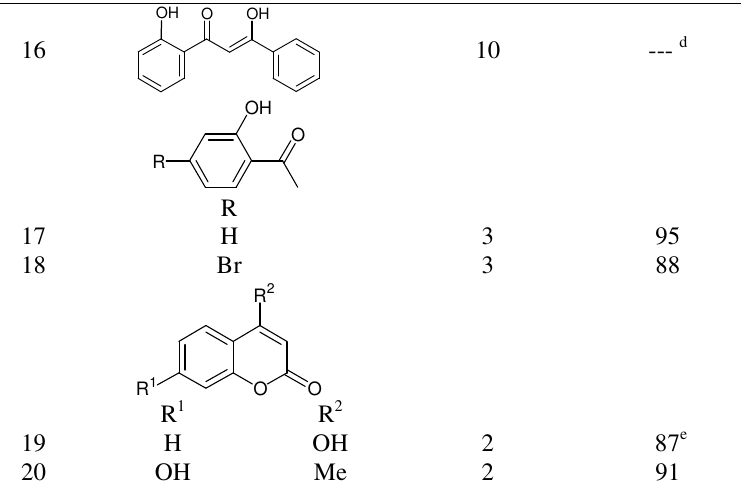
Table 3. WD-Acetylation of amines and thiols with Ac Compound Reaction time, h Yield of amides and thiol esters, % PhNH 0.25 2